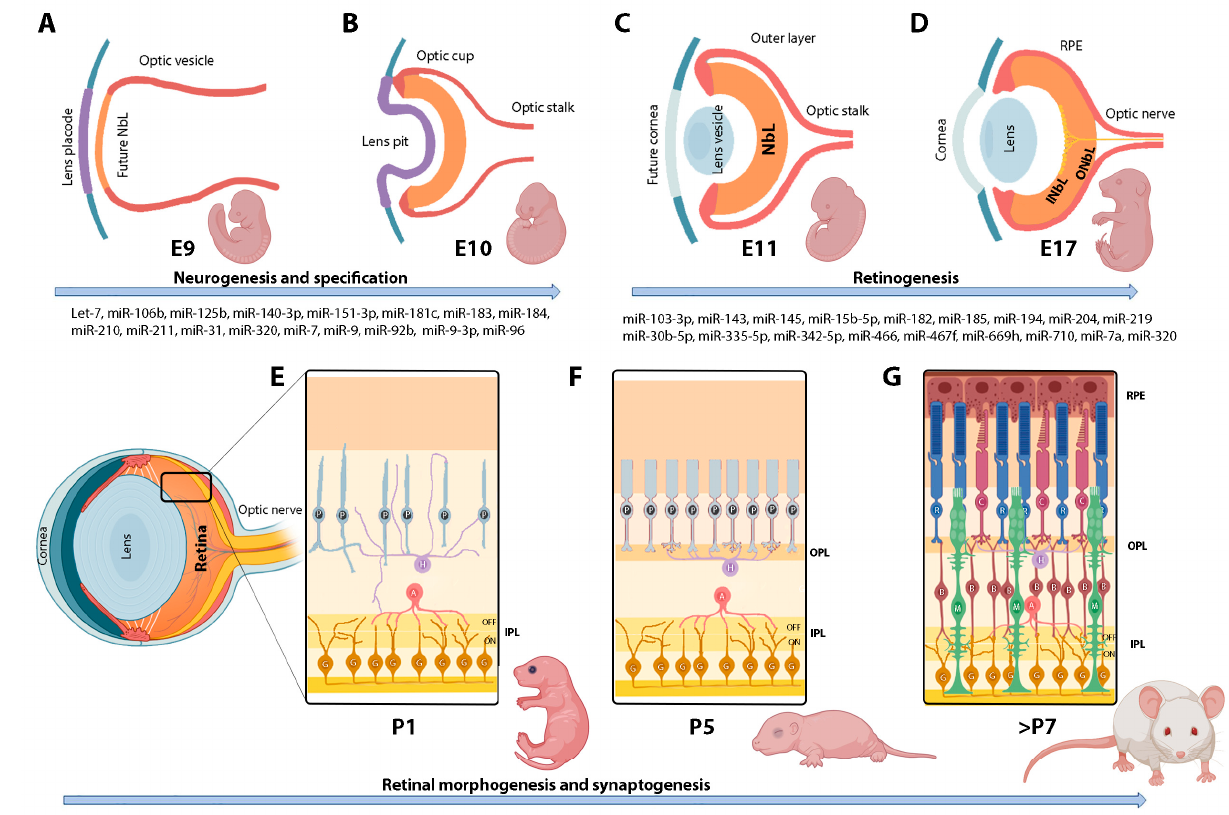
Figure 1. Schematic summary of the developing mouse retina and main miRNAs involved. ( A – D ): Schematic showing the various stages of eye development, from optic vesicle formation until the specification of the outer (ONbL) and inner neuroblastic layer (INbL). ( E – G ): Schematic showing the neural stratification and the sequence of circuit assembly in the mouse retina. E = embryonic day; P = postnatal day. IPL = inner plexiform layer; OPL = outer plexiform layer; RPE = retinal pigment epithelium. G = retinal ganglion cells; A = amacrine cells; H = horizontal cells; B = bipolar cells; P = Photoreceptors; C = cones; R = rods; M = Müller glia. Figure created with BioRender (https://biorender.com/, URL accessed on 20 January 2023).